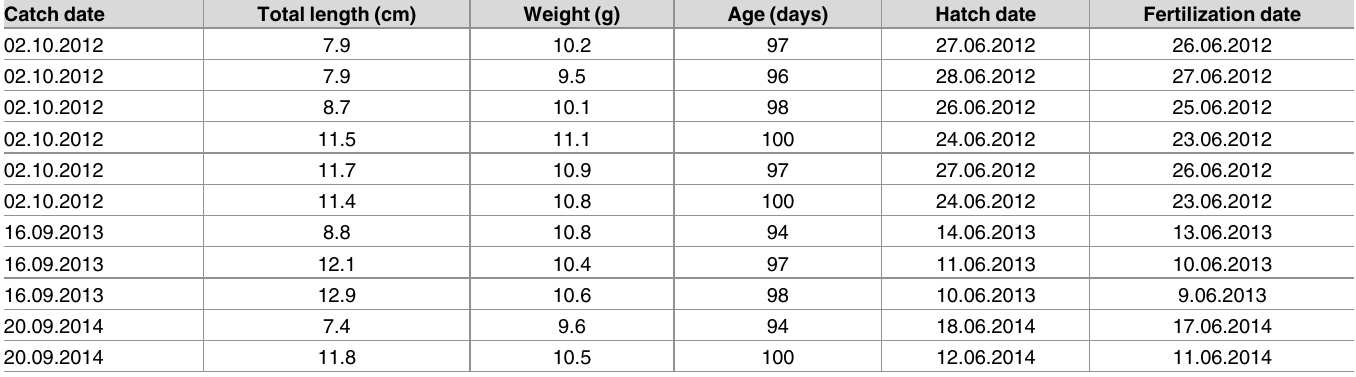
Table 1. Catch date, total length (TL), weight (g), age (in days) as well as hatch and fertilization dates for all specimens of YOY bighead carp exam- ined in this